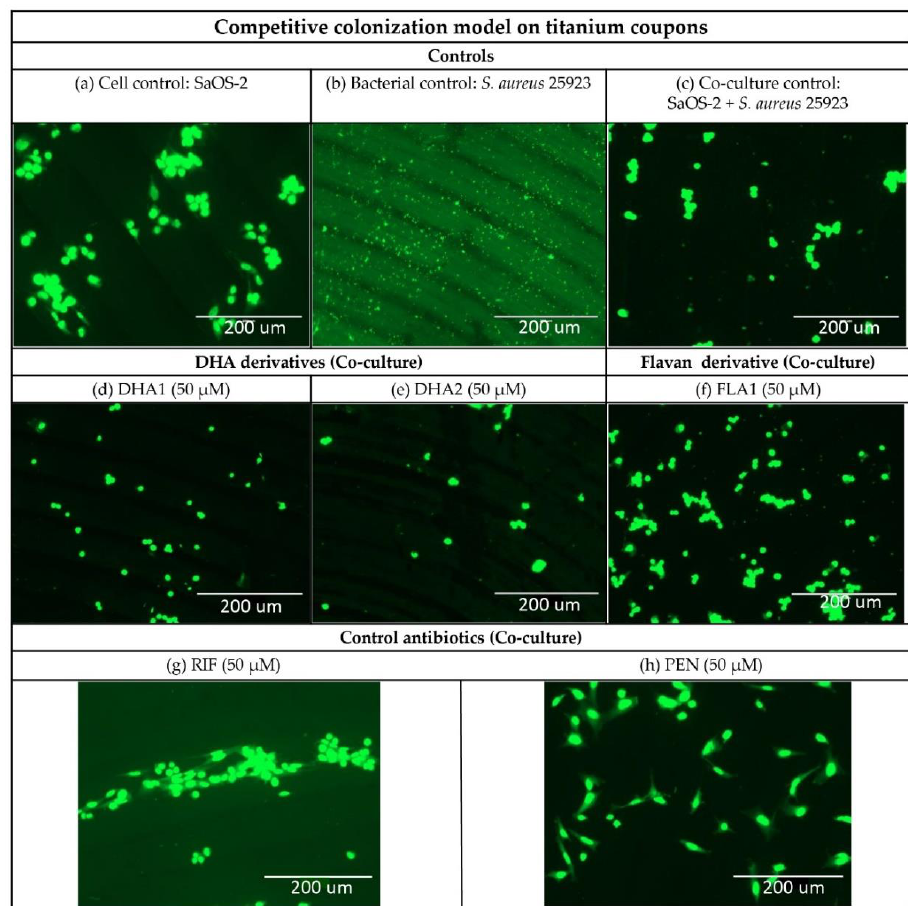
Figure 5. Representative fluorescence microscope images of titanium coupons treated under different conditions in the competitive colonization model. Upper row of the images (Figures 5a–c) correspond to the controls: ( a ) titanium covered by 10 5 human cells/mL (cell control); ( b ) titanium covered by 10 4 CFU/mL of S. aureus ATCC 25923 (bacterial control), and ( c ) 10 4 CFU/mL of S. aureus ATCC 25923 and 10 5 human SaOS-2 cells/mL (co-culture control). Middle row of images (Figures 5d–f) correspond to titanium coupons with the two DHA derivatives ( d ) DHA1 and ( e ) DHA2 , and the flavonoid-derivative ( f ) FLA1 , all added at a concentration of 50 µM and co-cultured with S. aureus ATCC 25923 and 10 5 human SaOS-2 cells/mL. The bottom row of images (Figures 5g,h) are representative images of titanium coupons with the two control antibiotics ( g ) RIF and ( h ) PEN , all added at a concentration of 50 µM and co-cultured with 10 4 CFU/mL of S. aureus ATCC 25923 and 10 5 human SaOS-2 cells/mL. The samples were stained with acridine orange (BD Diagnostics, Sparks, MD,